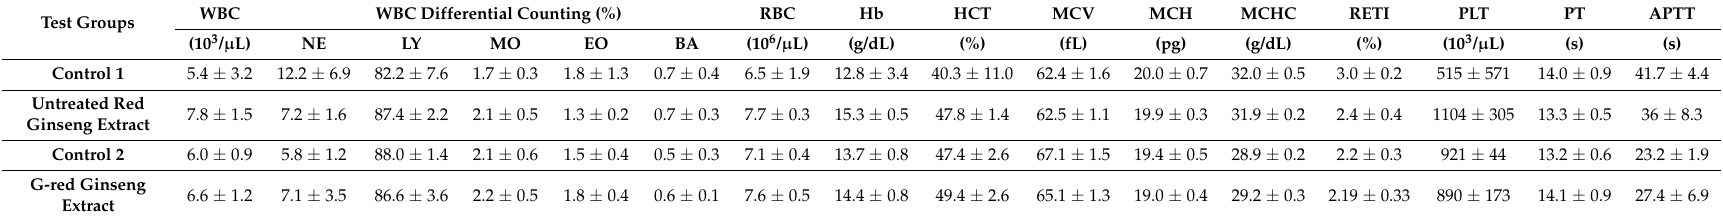
Table 3. Hematological and coagulation time values in rats after 14-day repeated oral administration of G-red ginseng extract or untreated red ginseng extract. Test Groups